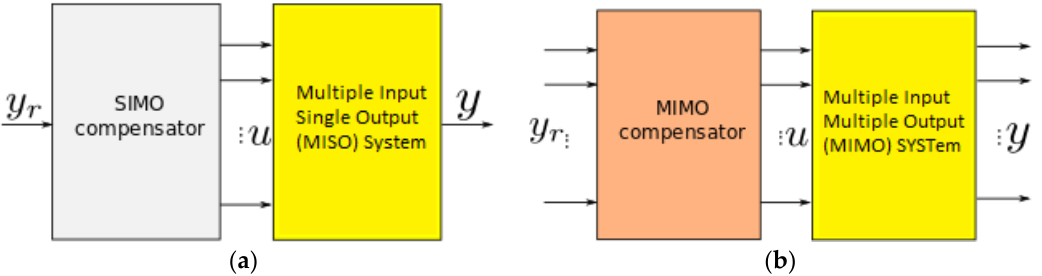
Figure 1. Feedforward control of badly damped vibrations. ( a ) control of SIMO (single input multiple outputs) systems [22]; ( b ) generalized control for MIMO (multiple inputs multiple outputs) systems.